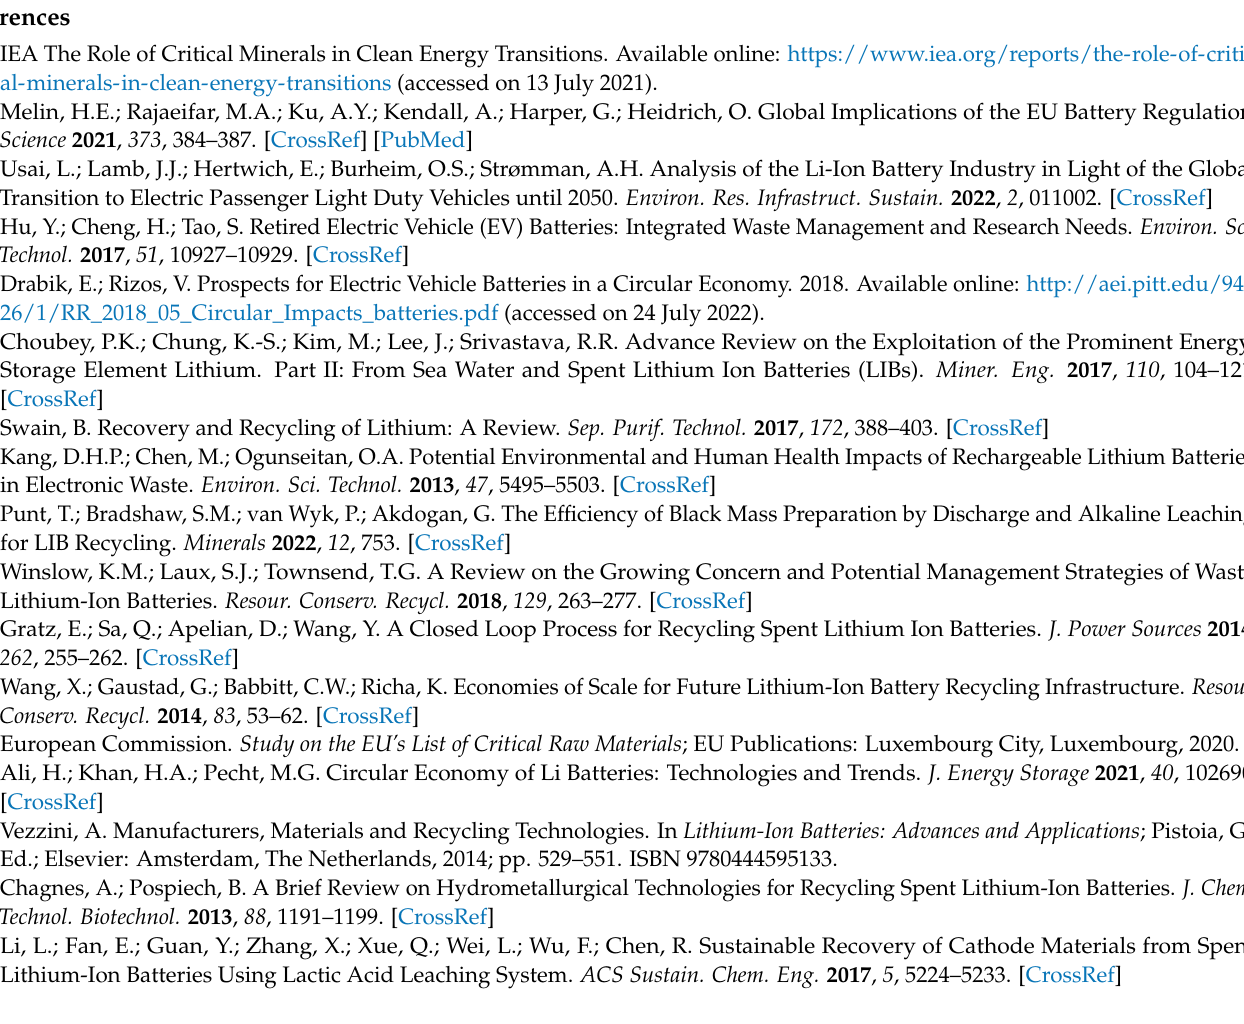
Figure A3. STEM image 3 with HAADF mapping of third phase. Vesicles: bright and dark amorphous areas with distinct boundaries indicated by black and white arrows, respectively; films: filamentous grey regions surrounding vesicles indicated by yellow arrows; wormlike structures: black linear regions within the light vesicles indicated by blue arrows).